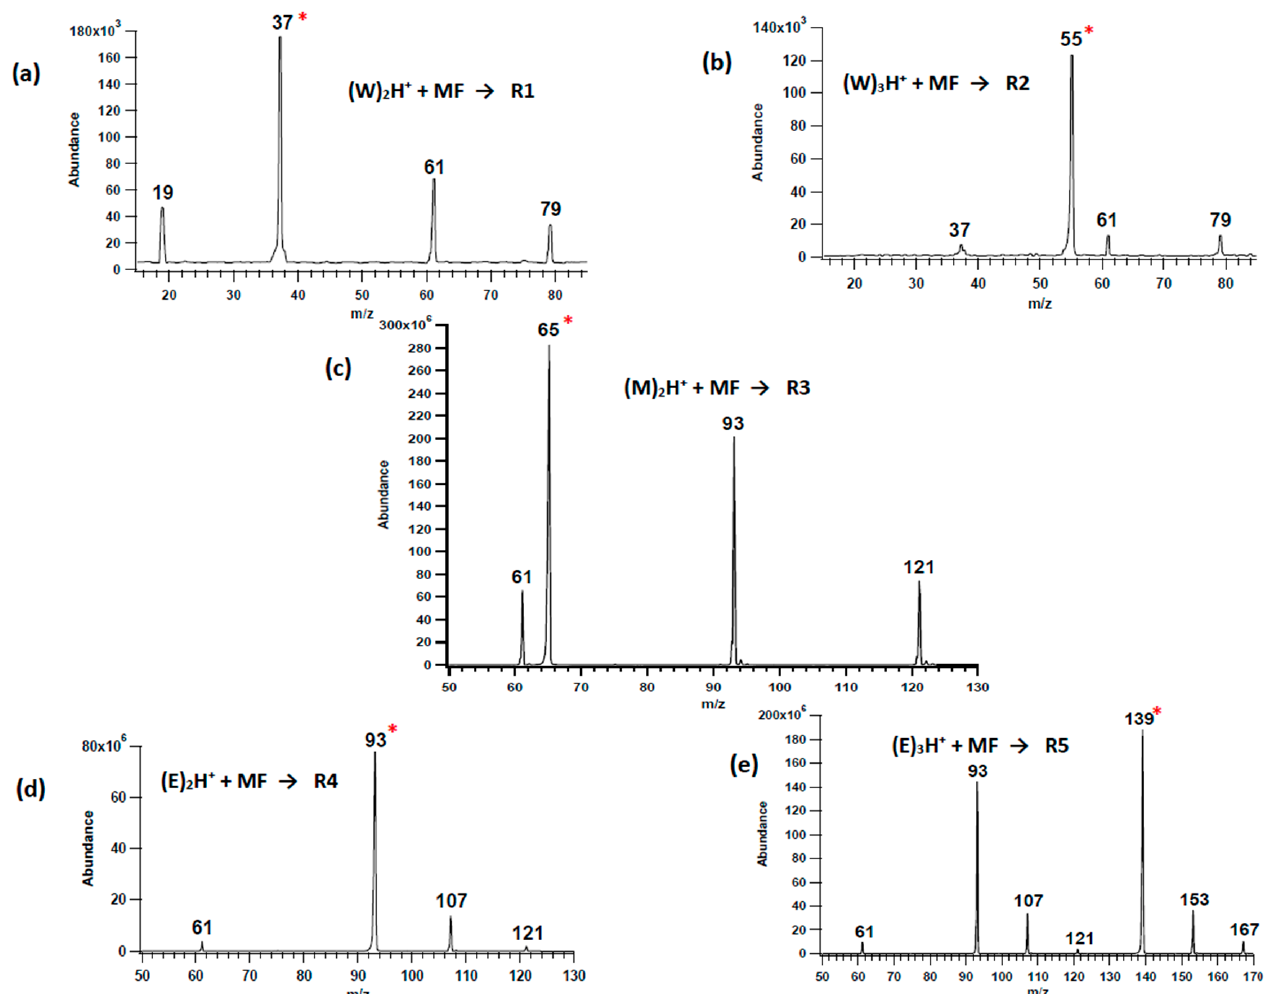
Figure 1. Representative mass spectra of neutral methyl formate reacting with ( a ) water dimer ion ( m/z 37, R1), ( b ) water trimer ion ( m/z 55, R2), ( c ) methanol dimer ion ( m/z 65, R3), ( d ) ethanol dimer ion ( m/z 93, R4), and ( e ) ethanol trimer ion ( m/z 139, R5). The red asterisk highlights the reacting cluster ion.